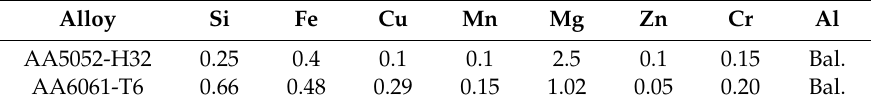
Table 2. Chemical composition of the heat-treated base materials (wt%).